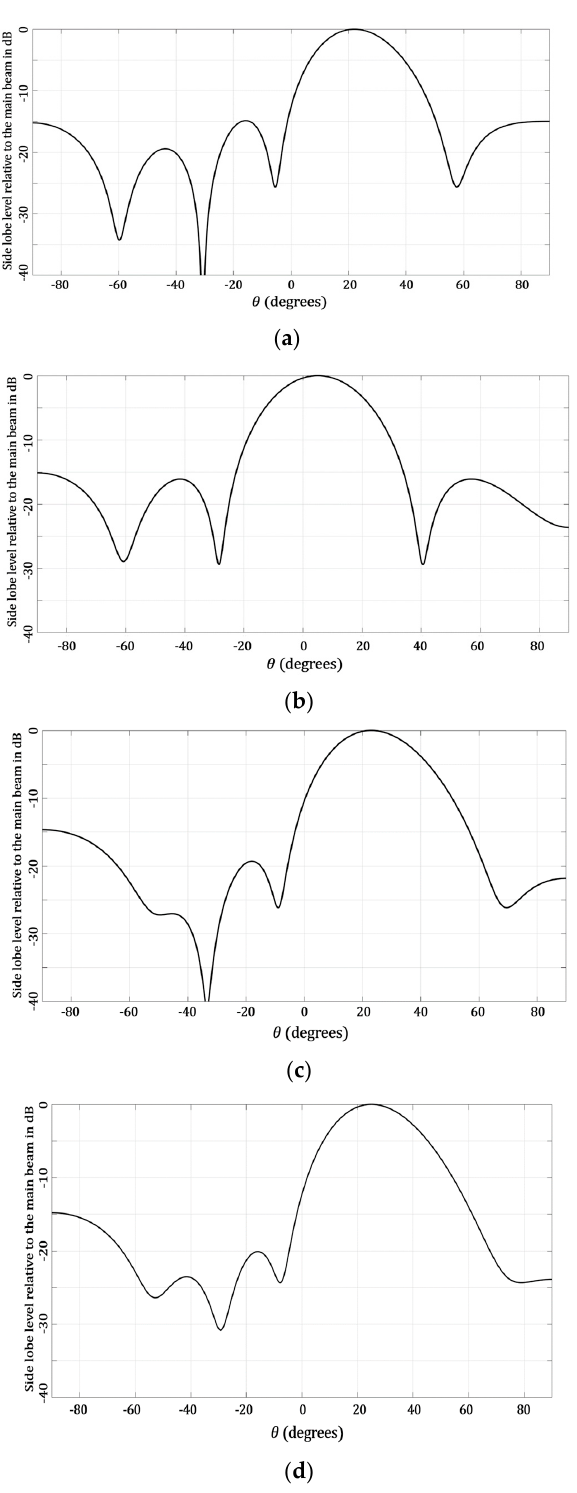
Figure 9. Radiation pattern obtained for the maximum scanning direction for the following: ( a ) golden angle, ( b ) angle optimization, ( c ) raised cosine and ( d ) amplitude optimization.